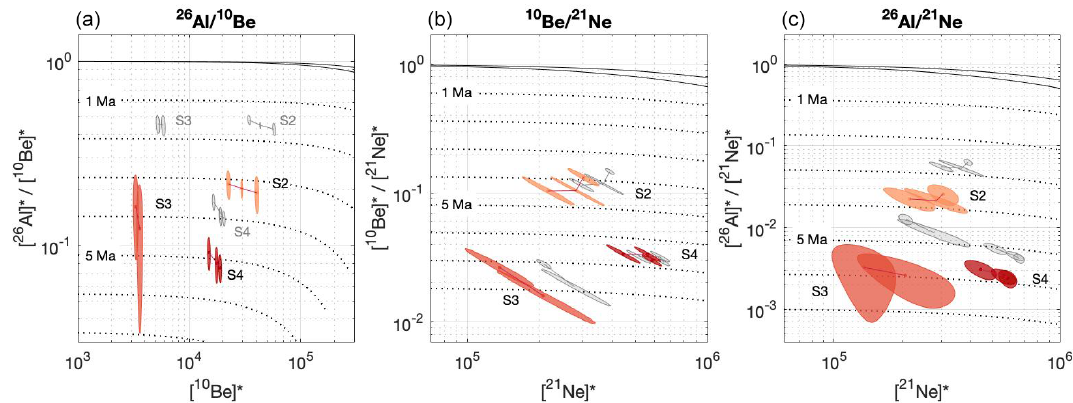
Figure 10. Paired-nuclide diagram for (a) 26 Al– 10 Be, (b) 10 Be– 21 Ne, and (c) 26 Al– 21 Ne pairs. Solid black lines show the steady-state erosion zone, and dashed lines show the burial lines as million-year decay isochrons. The nuclide concentration for each data point is represented by a shaded ellipse of its 1 σ uncertainty. Grey data points show the measured nuclide concentrations for the paleo-surface samples as described in Fig. 9d–e. Shaded red data ellipses show the resulting nuclide concentrations when subtracting the modeled nuclide concentration from the measured. The burial age (dashed isochron lines) for which a sample lies represents the apparent burial age and is the maximum single period the sample has been buried since current time. Color shades refer to the different paleo-surface units as described in Fig. 7. ∗ signifies nuclide concentrations normalized to respective surface production